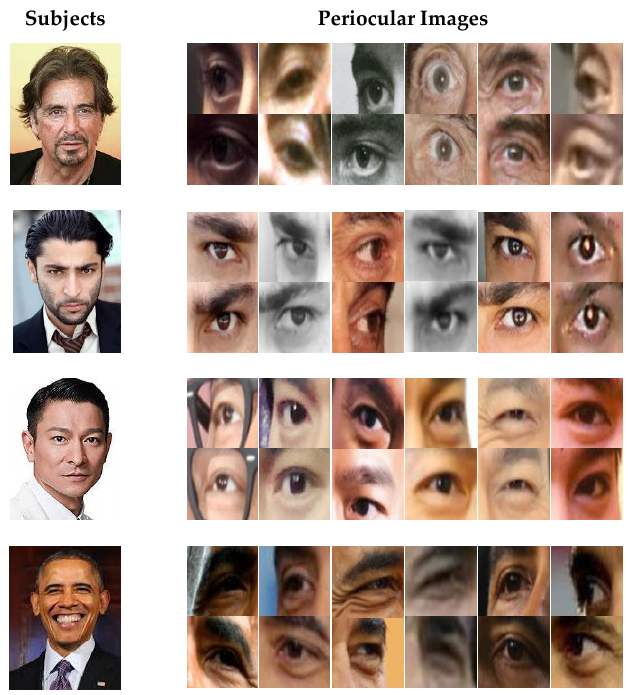
Figure 4. Samples of periocular images in the